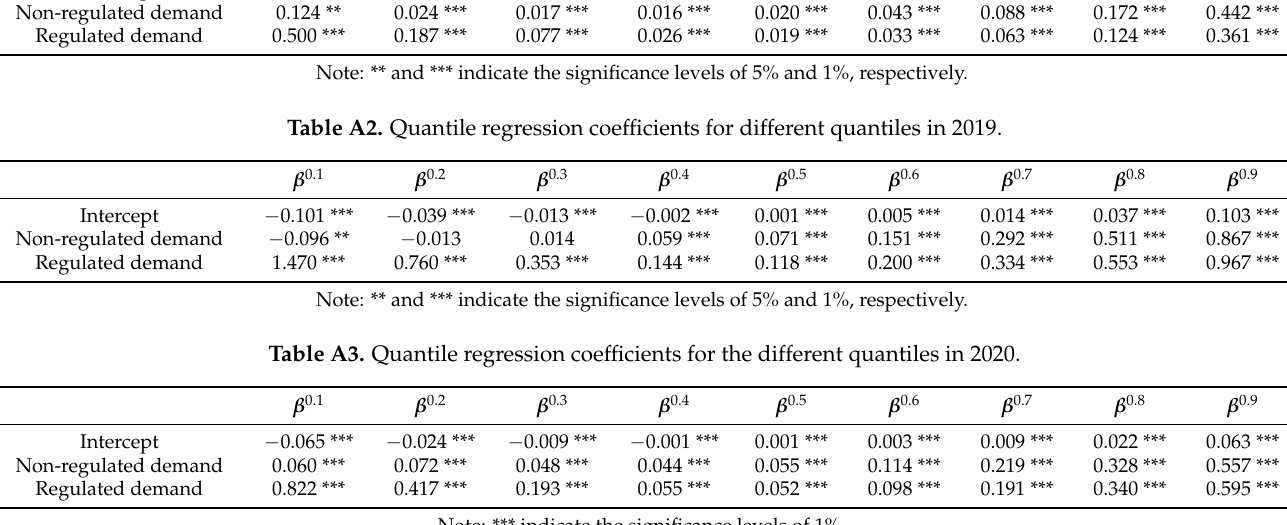
Table A1. Quantile regression coefficients for the different quantiles in 2018.